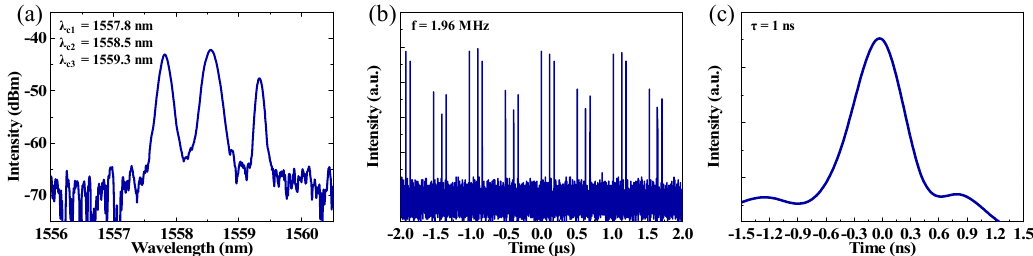
Figure 8. ( a ) Output optical spectrum, ( b ) typical pulse train, and ( c ) zoom in pulse profile.